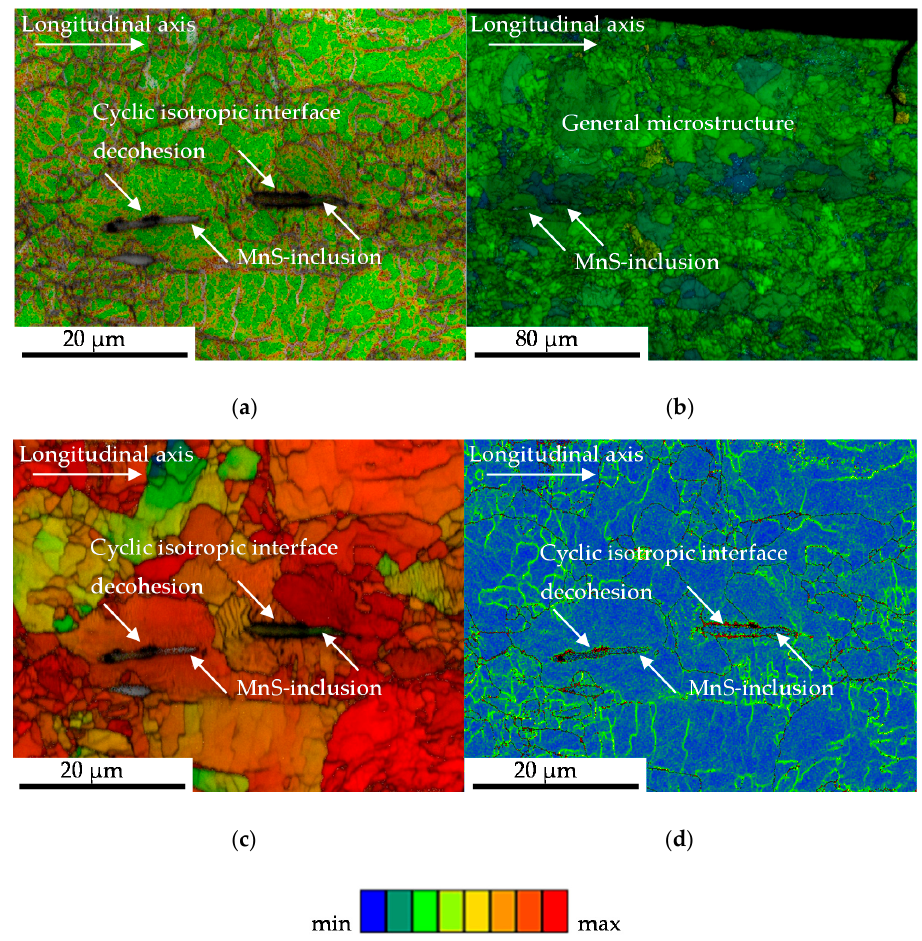
Figure 11. Electron Backscatter Diffraction-based analysis of MnS-inclusions and forming induced initial, respectively cyclic damage, in dependence on the microstructure after torsional loading with ( a ) Geometric necessary dislocation (GND) map; ( b ) Kernal average misorientation (KAM) map in higher magnification to give an overview over the surrounding microstructure; ( c ) Schmid-parameter map; ( d ) Grain average misorientation (GAM)